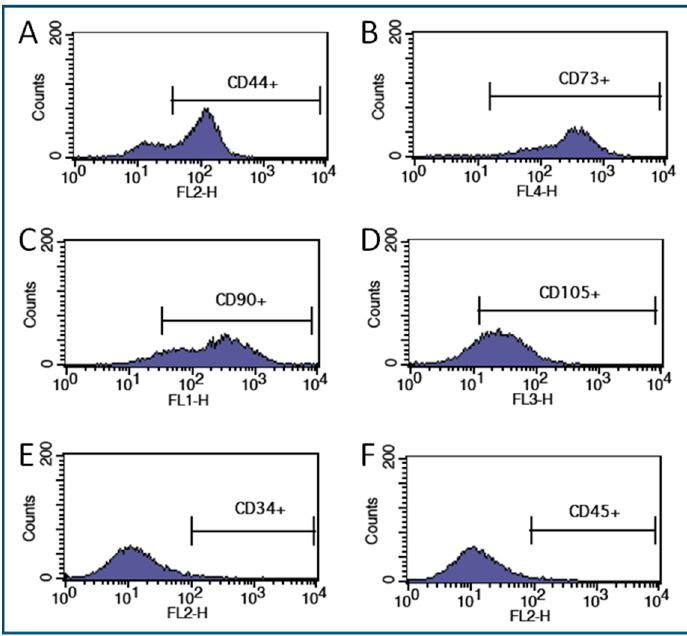
Figure 8. The histograms from flow cytometric analysis showing the presence of CD44 ( A ); CD73 ( B ); CD90 ( C ); CD105 ( D ); and the absence of CD34 ( E ); and CD45 ( F ).